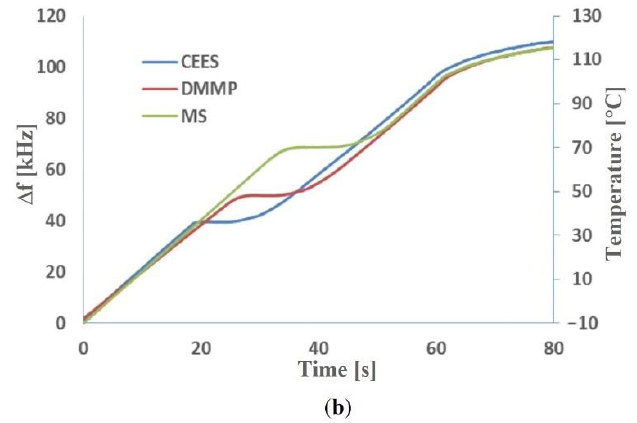
Figure 10. Application of the uncoated SAW sensor with temperature programmed desorption for CWA simulants detection: ( a ) changes in the resonant frequency of the sensor related to the various stages of the device operation; ( b ) the sensor responses resulting from the detection of the CEES, DMMP, and MS [75]. Reprinted with permission from [75]. Copyright 2021 IEEE.